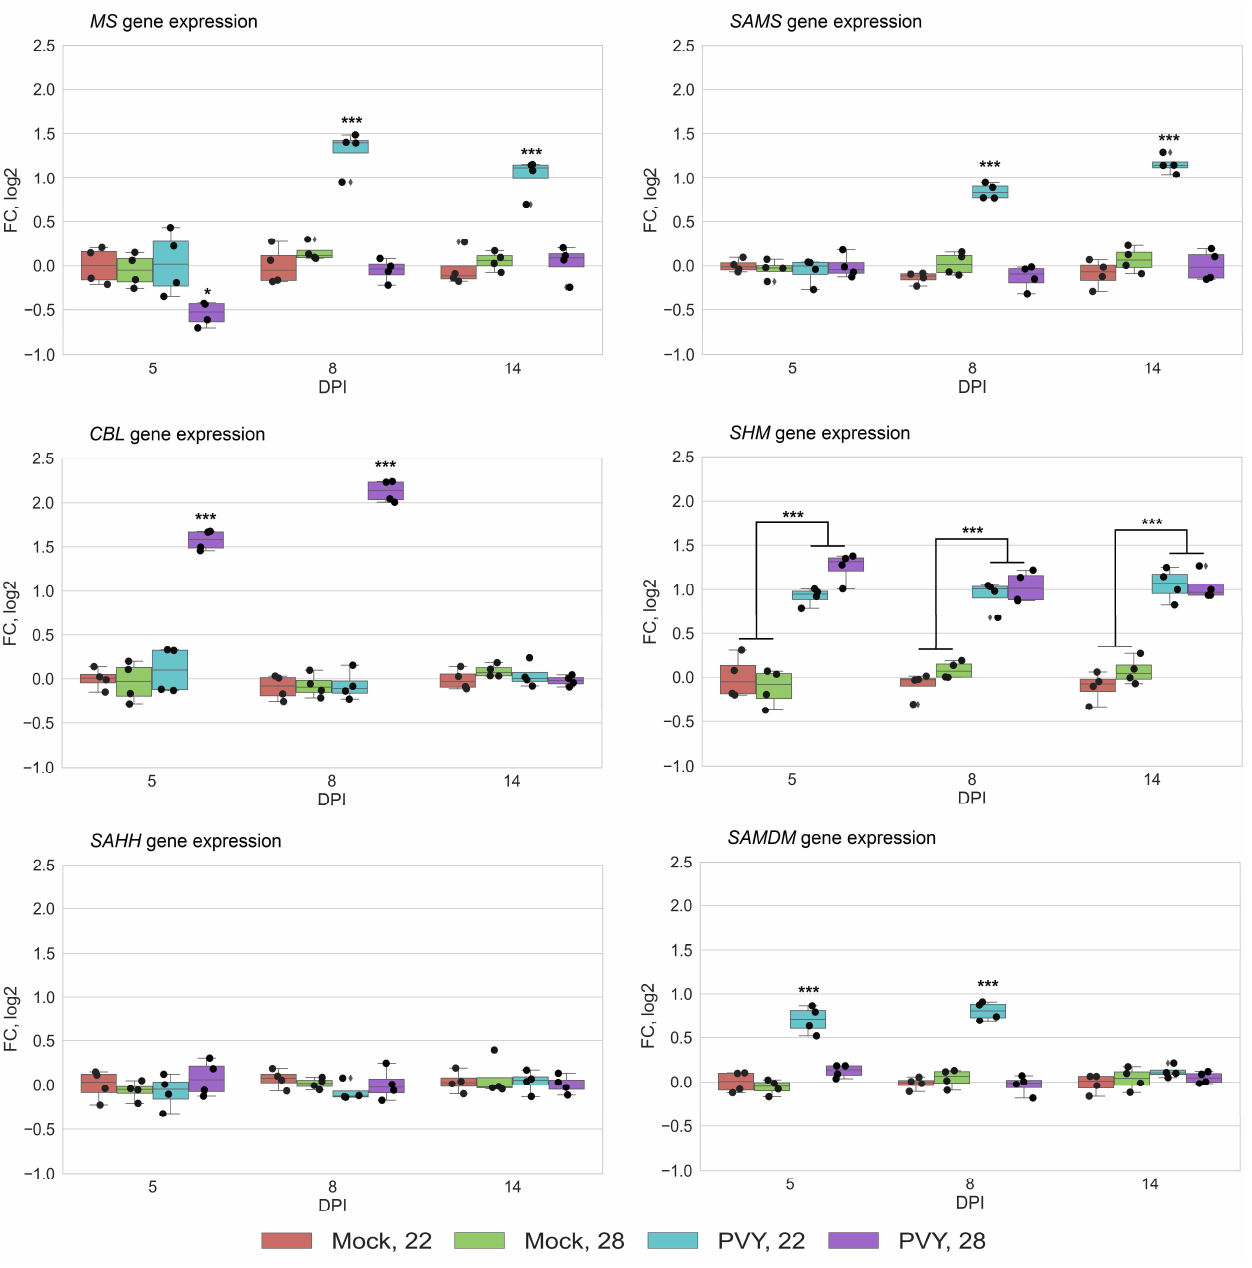
Figure 3. Expression level of methionine cycle (MTC)-related protein genes using quantitative reverse transcription PCR [RT-qPCR]) in systemically infected leaves of Gala plants at 22 or 28 ◦ C at five, seven, and eight days post-inoculation (dpi), as shown. CBL , cystathionine β -lyase; MS , methionine synthase; SAMS , S-adenosyl methionine synthetase; SHM , serine hydroxymethyltransferase; SAMDM , SAM dependent methyltransferase. Analysis of variance and Tukey’s HSD post hoc tests were performed for RT-qPCR data. *** p <